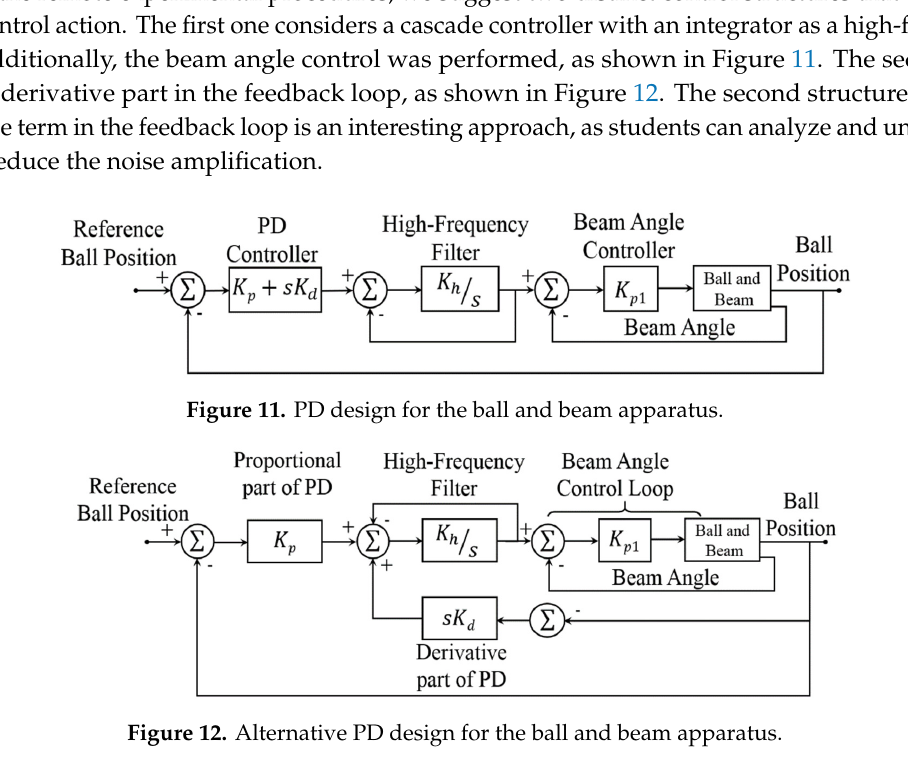
Figure 10. ELSA ‐ SP structure (adapted from [62]).